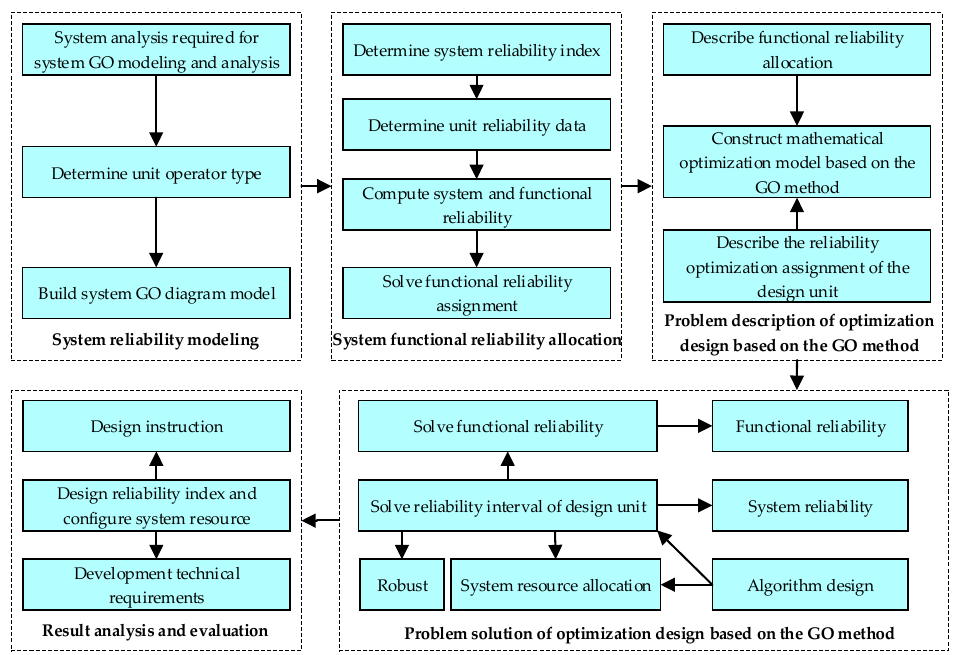
Figure 1. Process of diesel reliability optimization design based on the GO